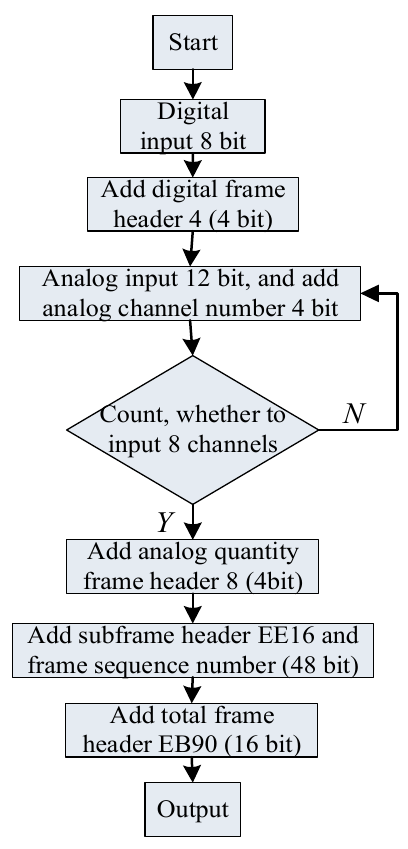
Figure 4. Image coding signal preprocessing.